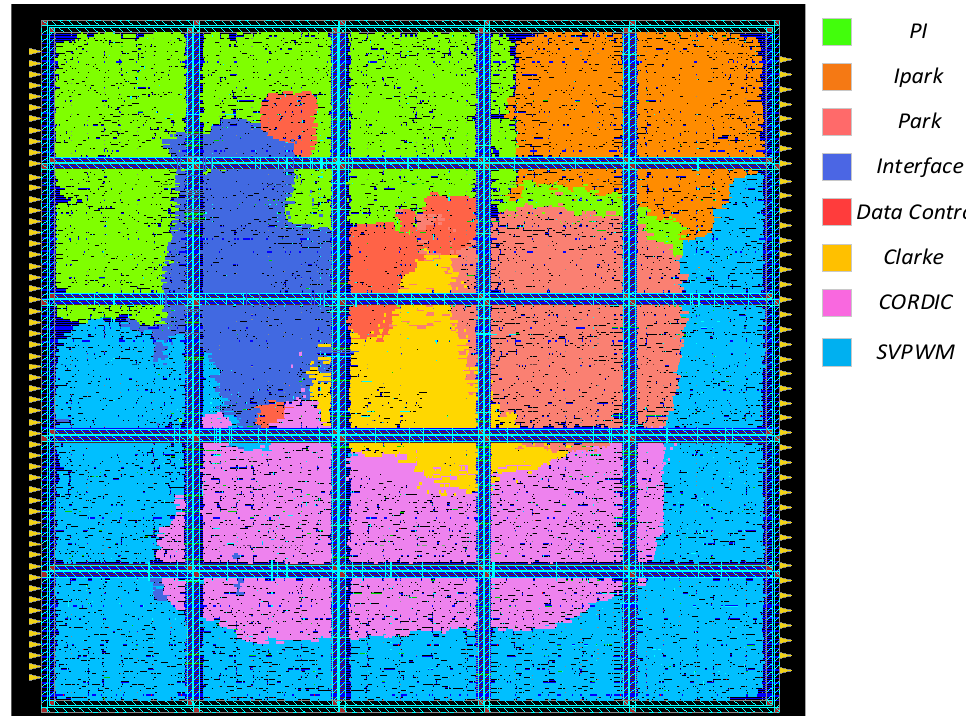
Figure 21. Layout diagram of